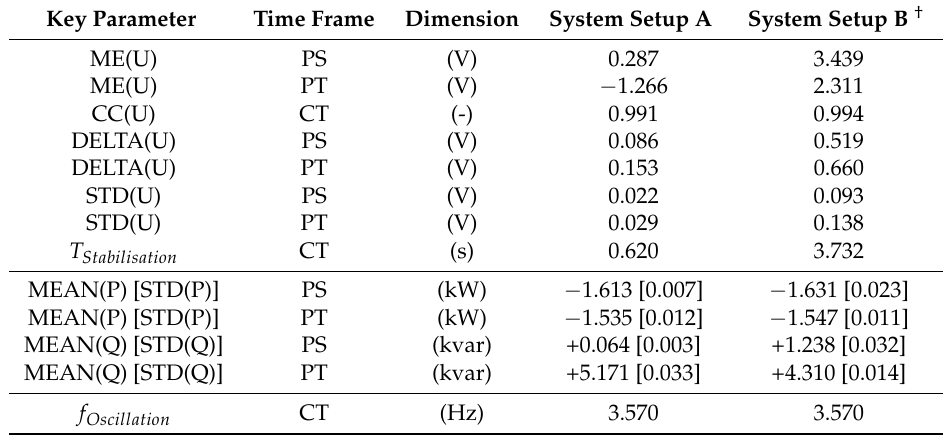
Figure 10. Comparison of the different system responses to the deviation voltage step. The reference curve is constructed by using the steady state results for given Q(U)-control. For System Setup B, varying time constants T C for the Q(U) controller of PV inverter are presented. The depicted values are RMS-values calculated on a one-period time frame. The dashed line represents the values for 1.05 p.u. as well as 1.08 p.u. which in turn are the setpoints for the break of the slope of the Q(U) controller. Table 5. Statistical key parameter for the characterisation of system response for the step change of Phase A of the